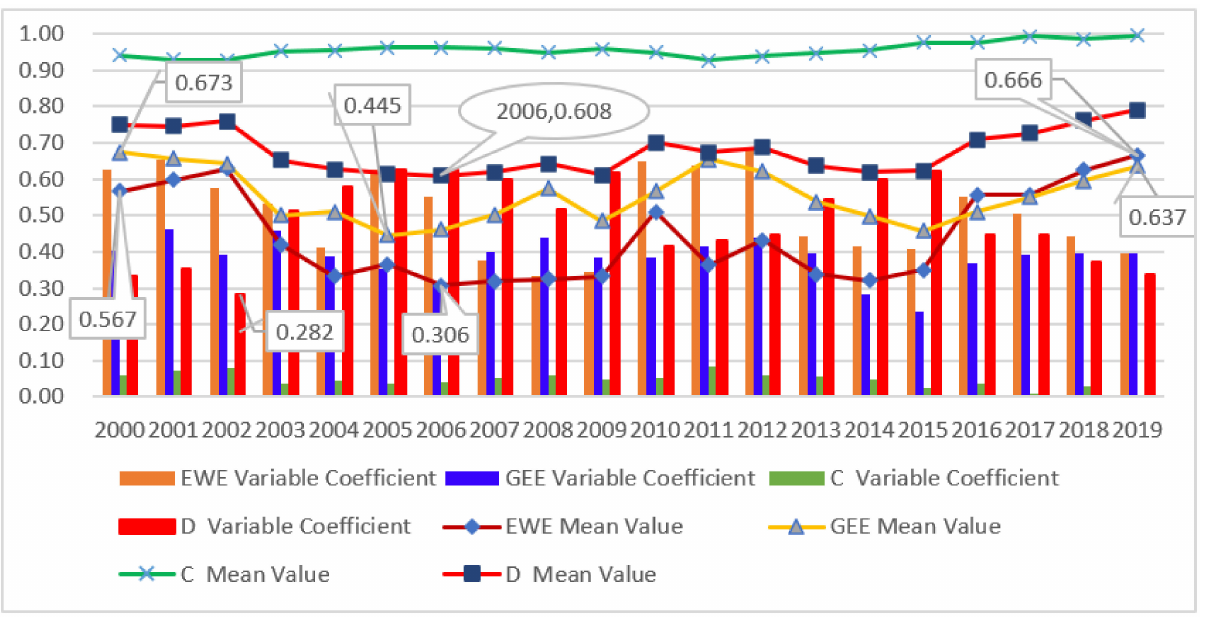
Figure 4. The dynamic evolution trend of green economic efficiency, ecological welfare performance, coupling degree, and coupling coordination